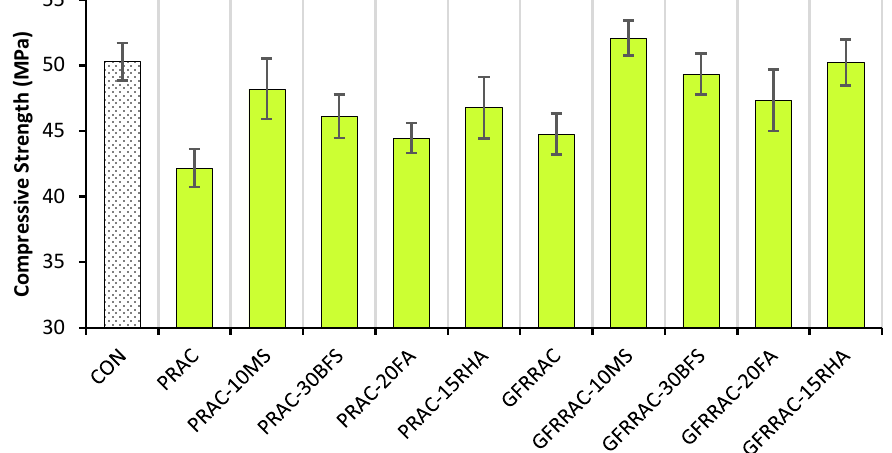
Figure 6. Compressive strength (f CS ) of PRAC and GFRRAC with different mineral